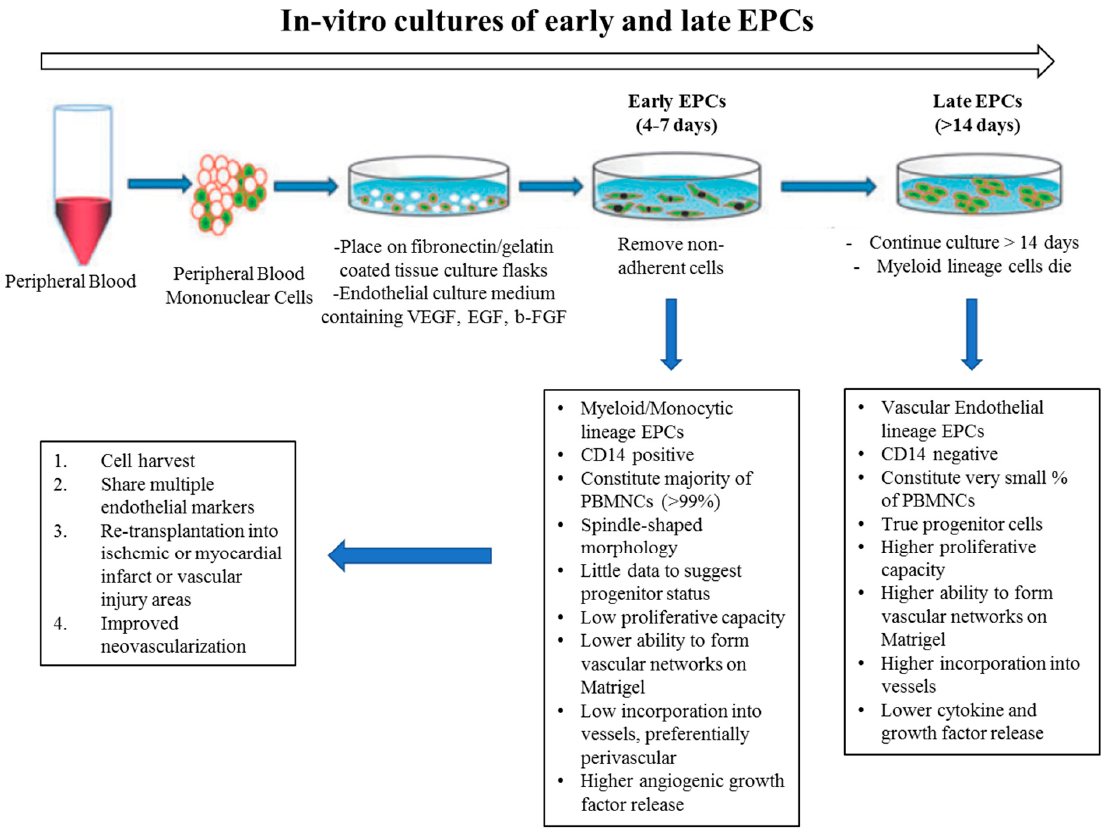
Figure 3. In vitro culture of endothelial progenitor cells (EPCs); early vs late outgrowth. EPCs are grown from whole peripheral blood mononuclear cells. Early EPCs are obtained from short term culturing (4–7 days) on fibronectin. A small population of EPCs when plated for >14 days is called late-outgrowth EPC (or ECFC) and demonstrate an increased capacity for proliferation and blood vessel formation. Illustration with permission from [64].